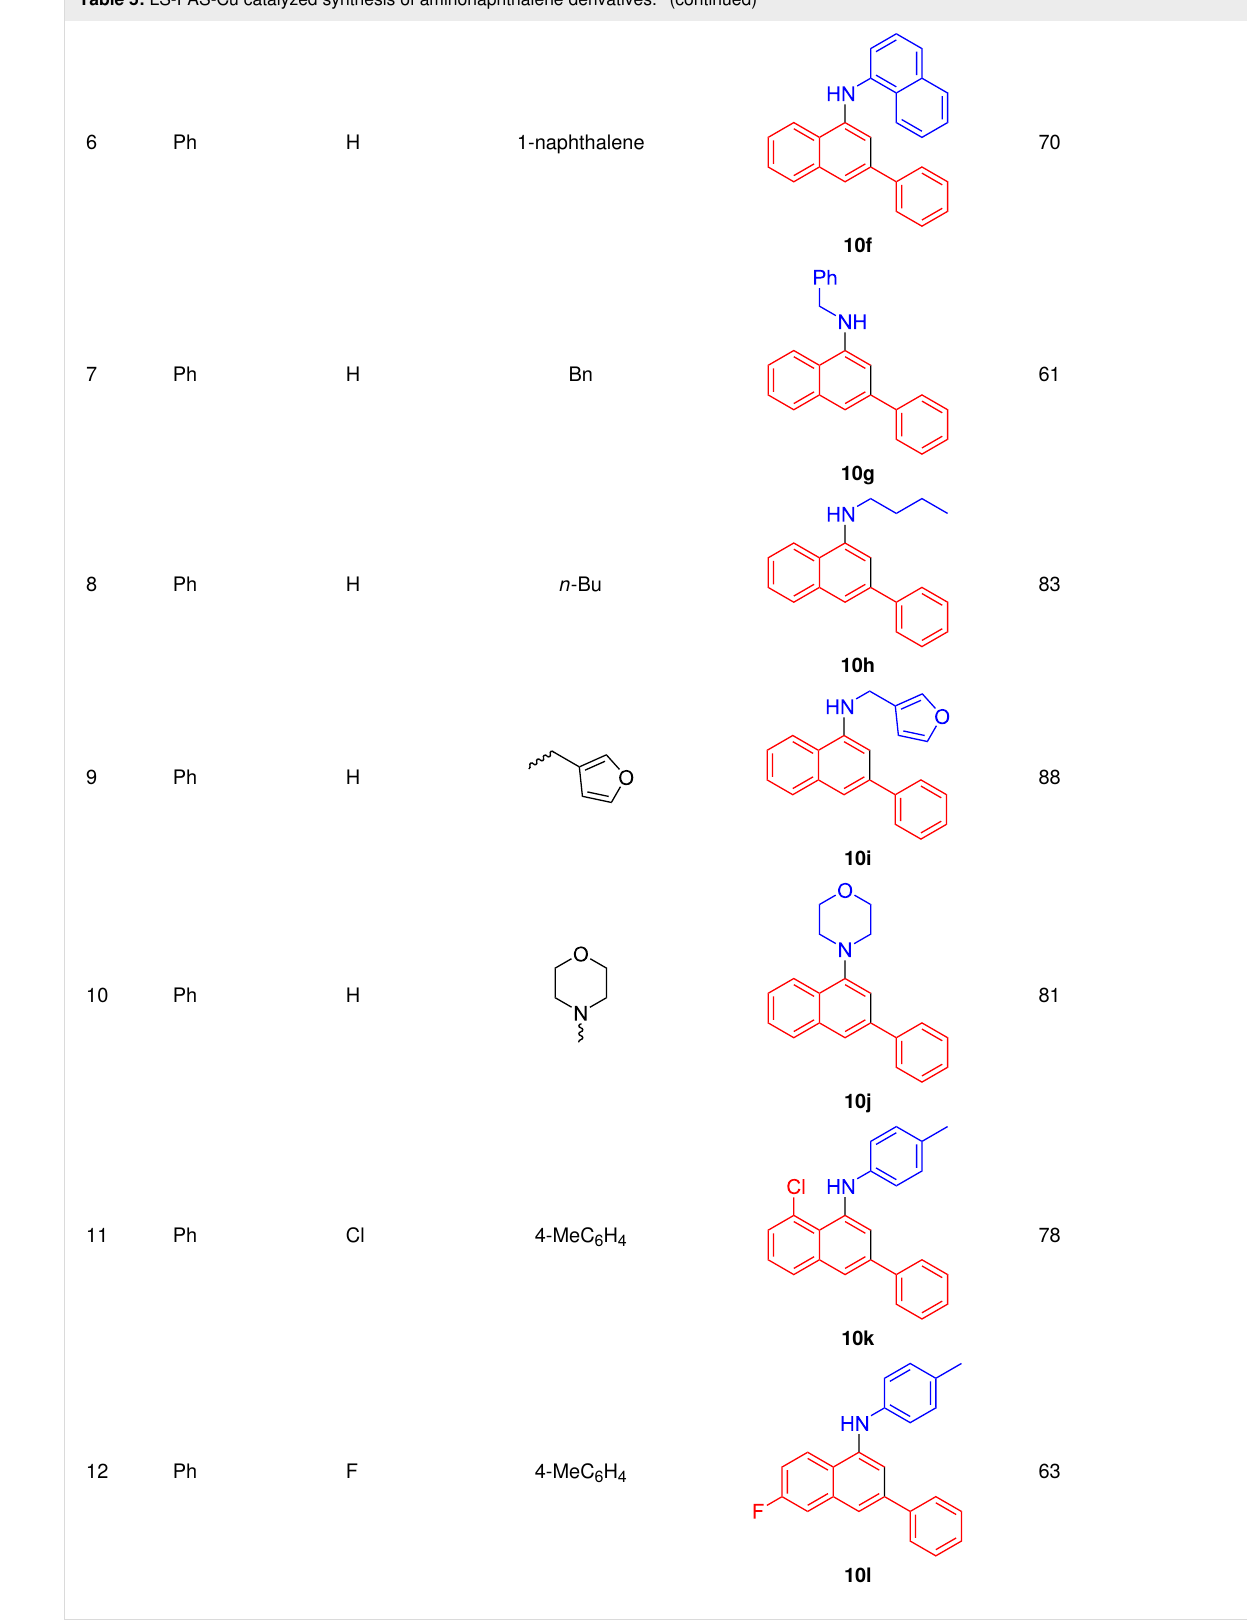
Table 5: LS-FAS-Cu catalyzed synthesis of aminonaphthalene derivatives. a